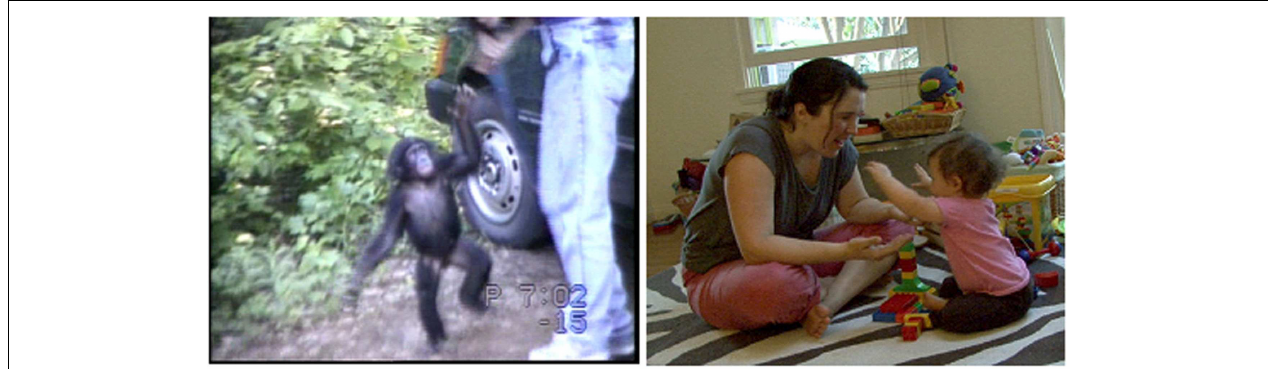
comes to Sue with arm raised for up . Sue puts Panpanzee down. Panpanzee briefly shoves Panbanisha and scampers off.Then Sue picks Panbanisha up.